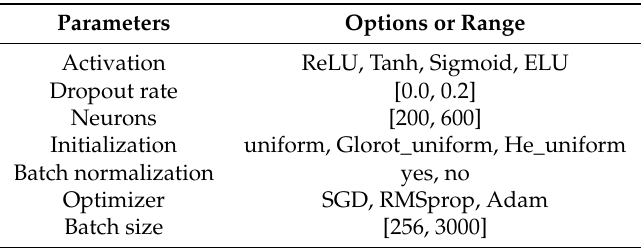
Table 1. The setting of random search for hyper-parameters optimization.